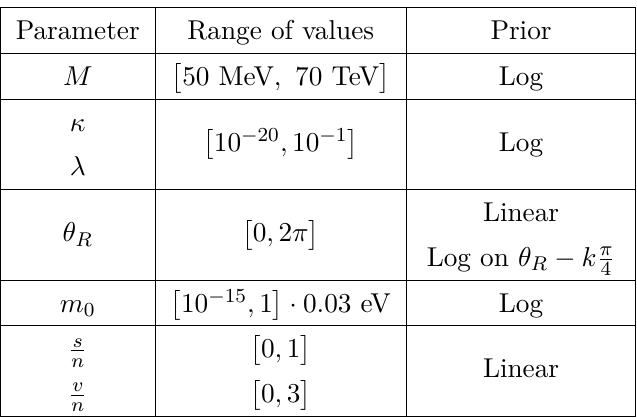
Table 4 . Range of values for the free parameters used in this analysis. “Prior” refers — in a slight abuse of terminology — to the measure in parameter space taken for the randomisation and is not meant to indicate a Bayesian parameter fit. Note k is an integer and its actual value depends on the case, Case 1) through Case 3 b.1). The ratio s/n is relevant for Case 1), Case 3 a) and Case 3 b.1), while v/n is relevant for Case 2). The rest of the parameters, group theory parameters and the angle θ , is determined by one of the representative examples, given in section L